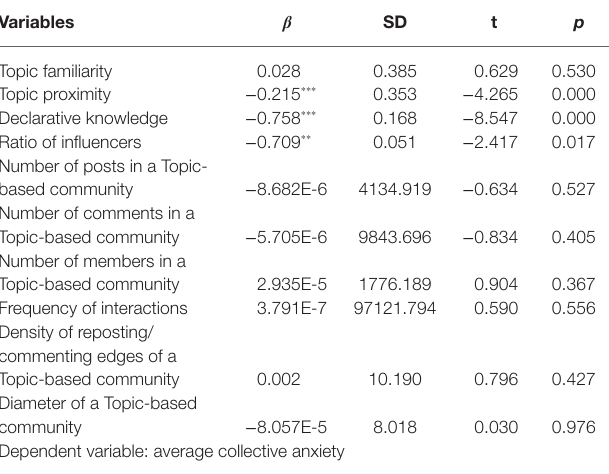
TABLE 3 | Regression output to predict collective